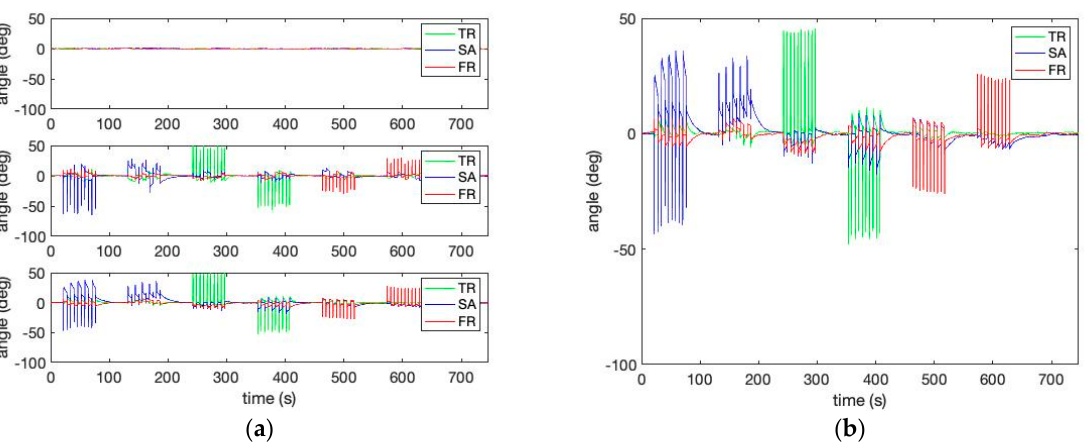
Figure 4. ( a ) Three-dimensional kinematics of the pitch (SA), yaw (TR), and roll (FR) angles of the three IMUs; ( b ) the combined three-dimensional kinematics of the pitch (SA), yaw (TR), and roll (FR) angles from the three IMU cluster system.